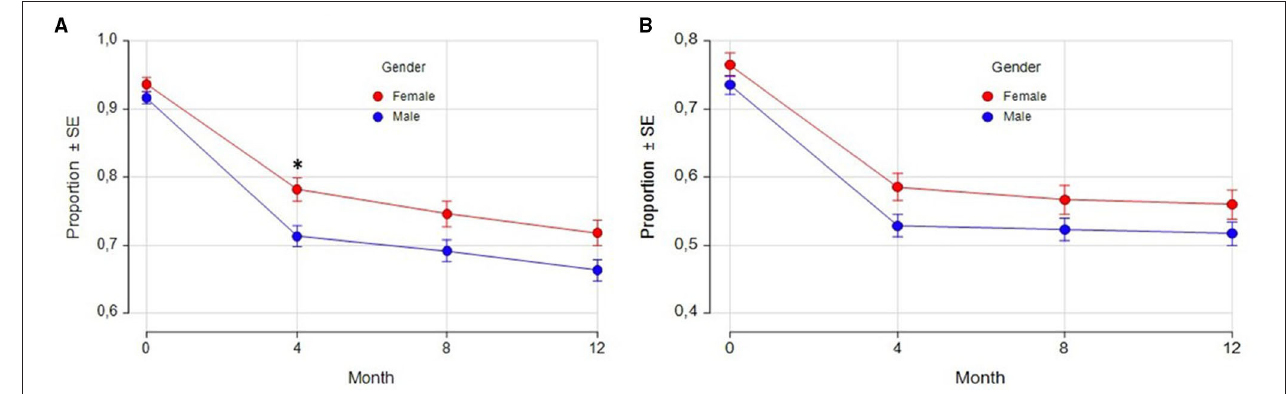
FIGURE 4 | Any fluctuations (A) and wearing-off (B) : proportion of patients by gender and visits. SE, Standard Error. * p = 0.0210 (difference between female and male proportions at follow-up visits adjusted for the difference between female and male proportions at baseline).